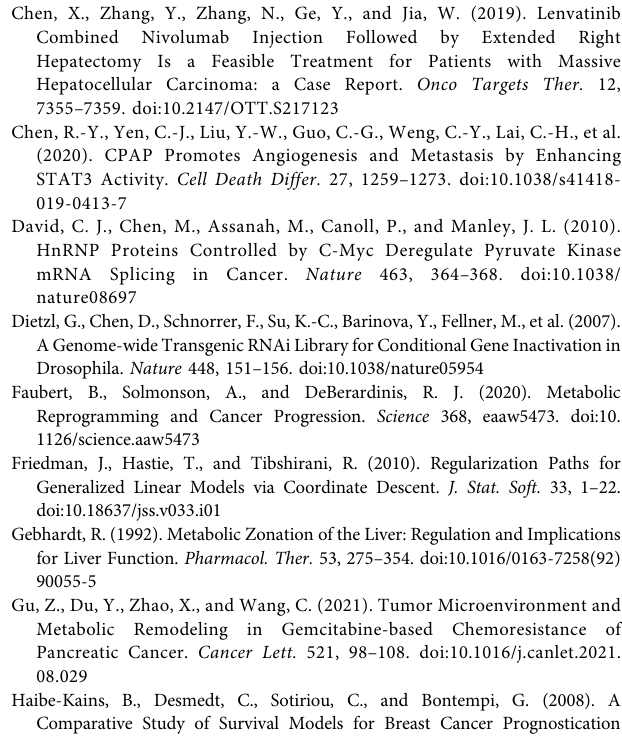
independent variable lambda; and the vertical axis represents the coef fi cient of the independent variable. Supplementary Figure S2 | GSVA of gene set enrichment in the high-risk group and low-risk group. (A) Heatmap of gene set enrichment in the high- and low-risk groups. Differential genes were mainly enriched in the tumor promoting/proliferation pathways and metabolism-associated pathways. (B) Heatmap shows metabolic rearrangements in the two risk